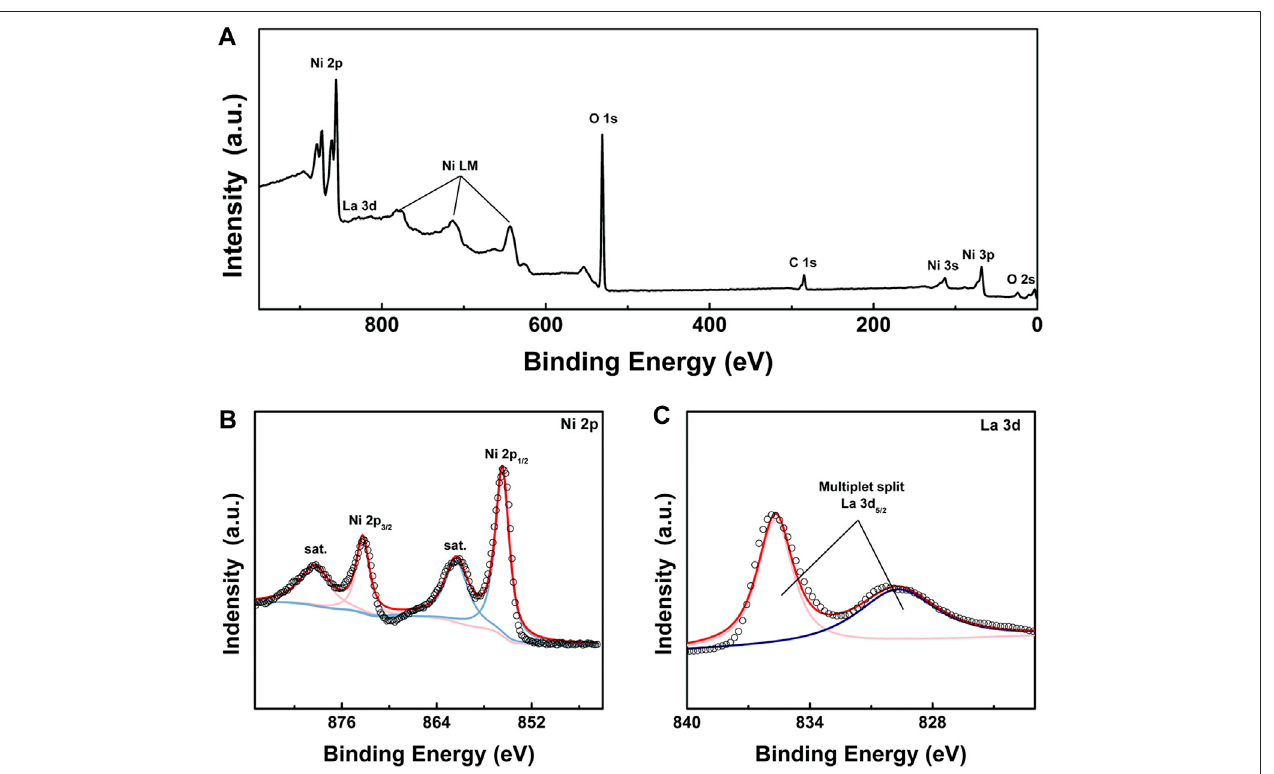
FIGURE 3 | (A) XPS spectrum of LONH; (B) high-resolution XPS spectra of Ni 2p in LONH; (C) high-resolution XPS spectra of La 3d in LONH.